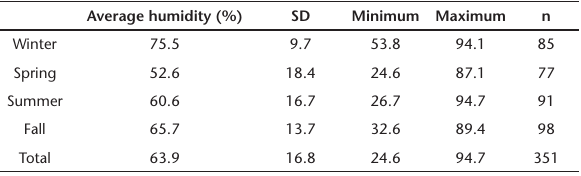
Table 1. Seasonal variation in the relative humidity of the air at São Jerônimo between March 2011 and October 2012.